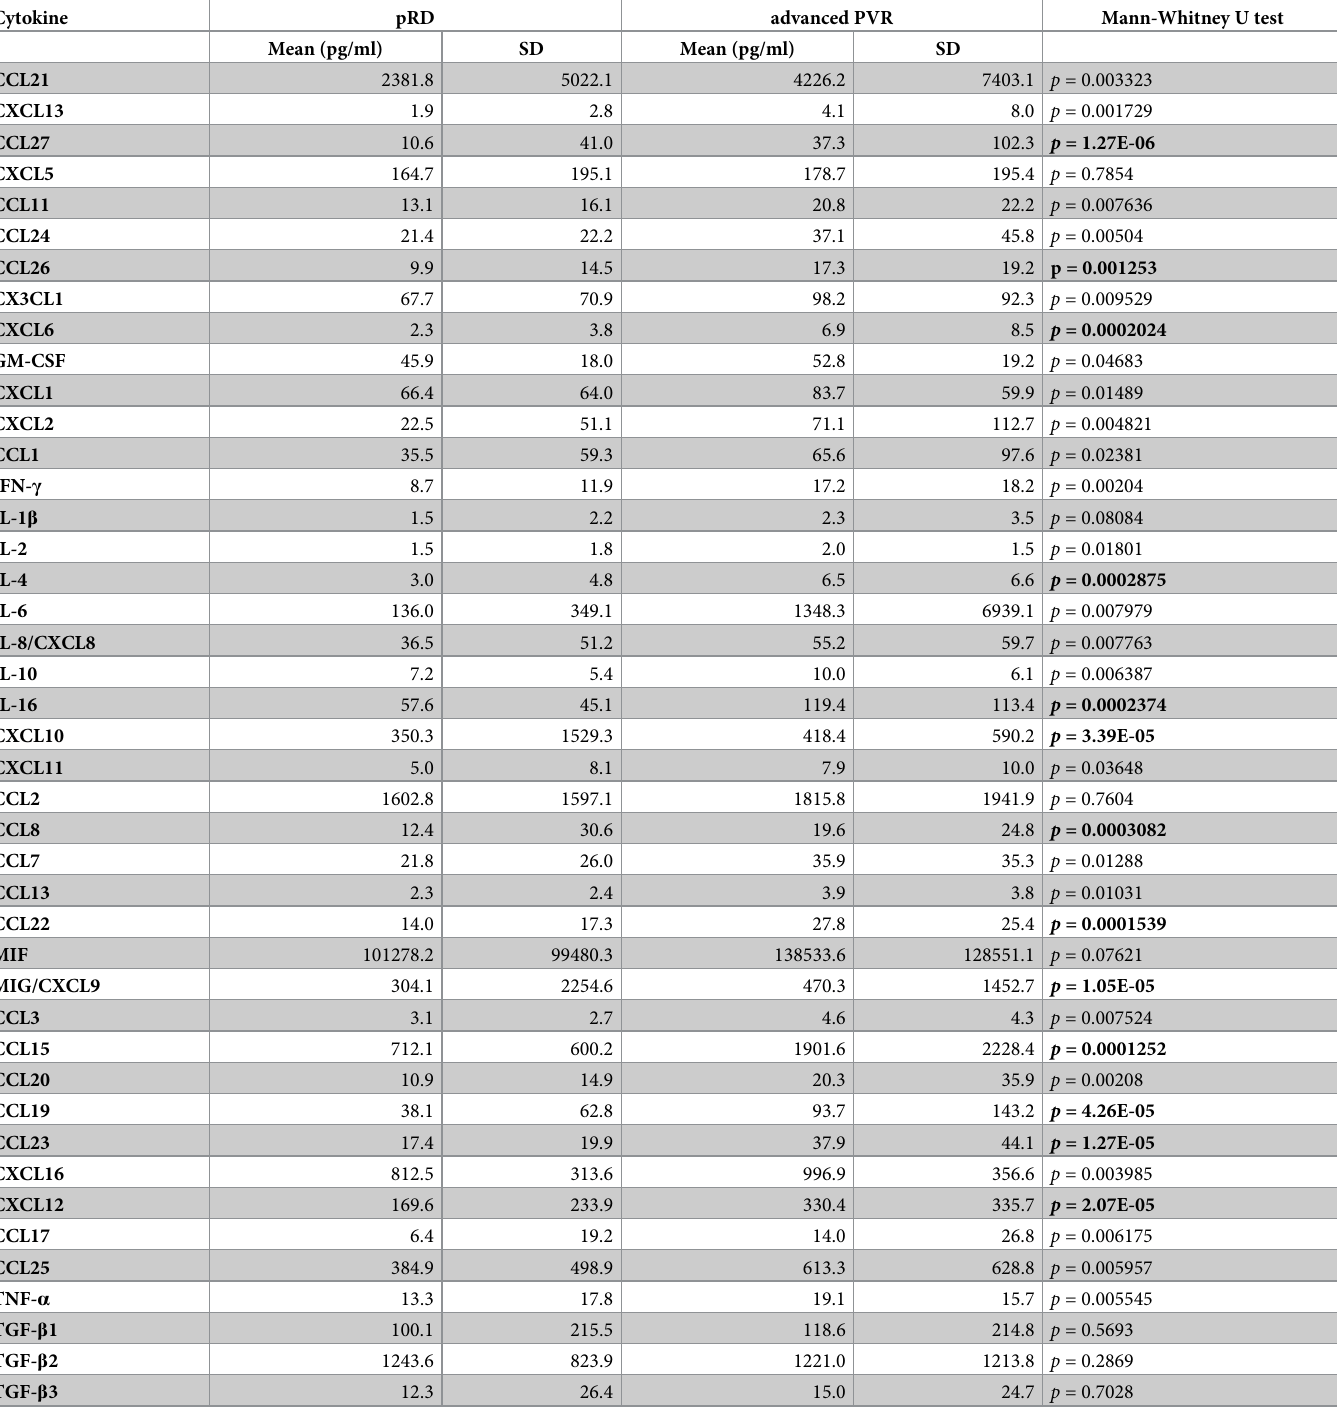
Table 2. Mean concentrations (pg/ml) and standard deviations (SD) of cytokines in the vitreous of eyes with primary retinal detachment without PVR (pRD) and in eyes with primary retinal detachment with advanced PVR requiring silicone oil tamponade. Cytokine pRD advanced